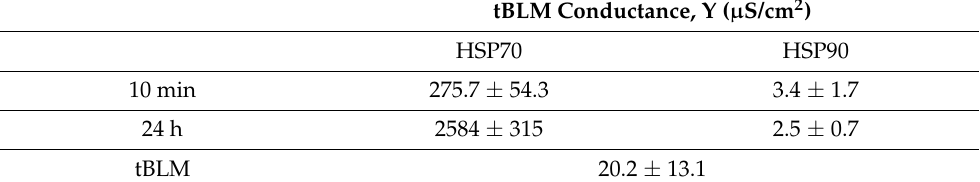
Table 2. Conductance of tBLM before and after incubation with HSP70 and HSP90. tBLM was composed from DOPC:CHO (in ratio % 60:40) in case of HSP70 and (in ratio % 75:25) in case of HSP90.